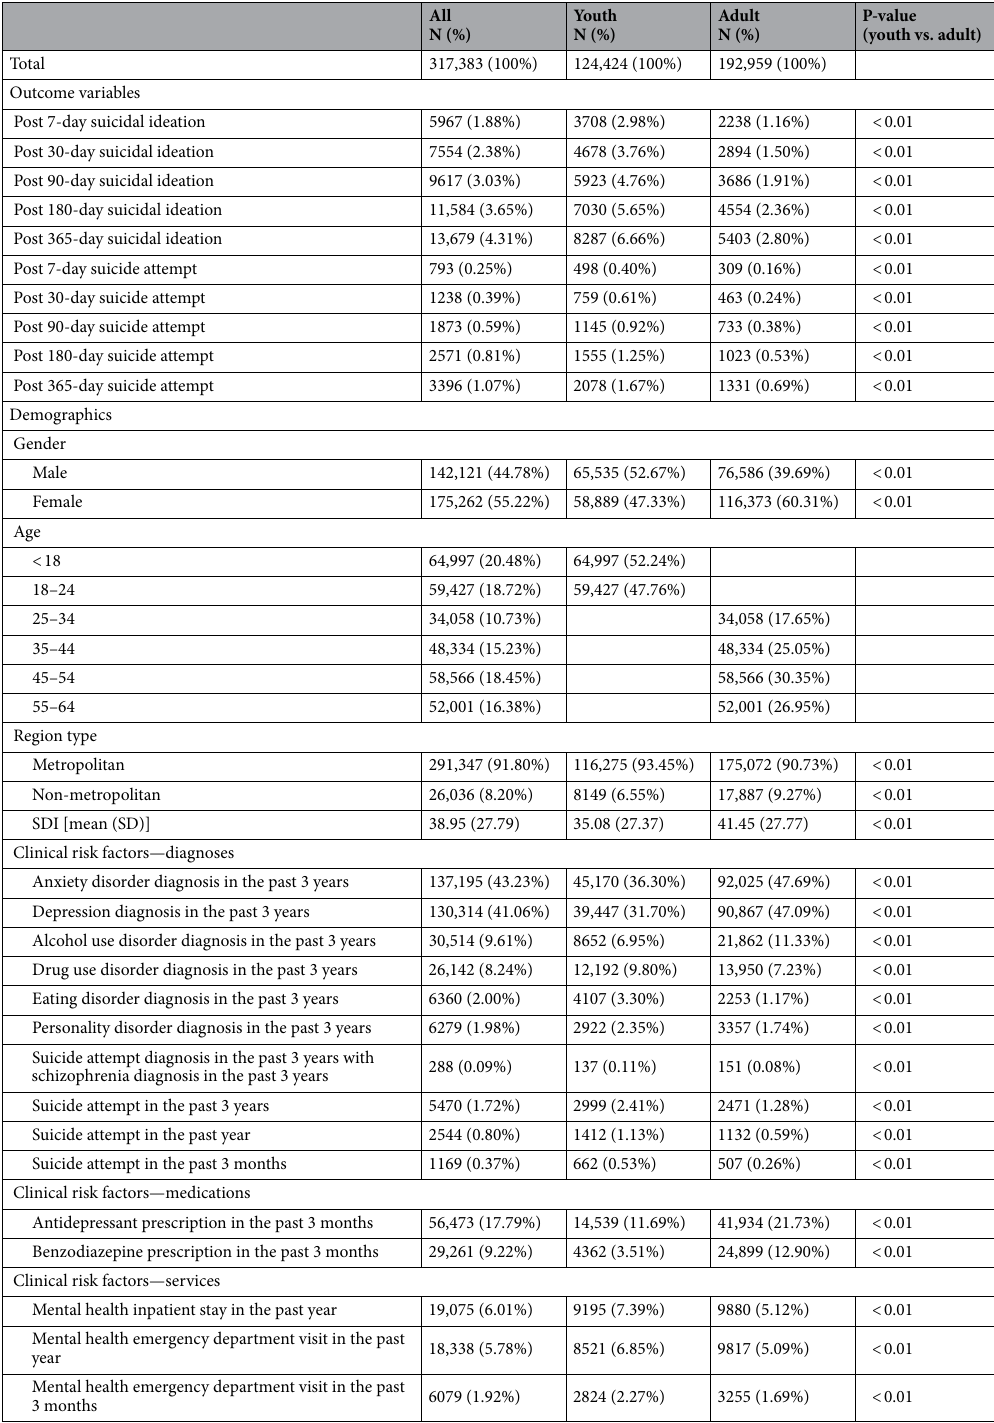
Table 1. Distributions of outcome variables, demographics, and risk factors by